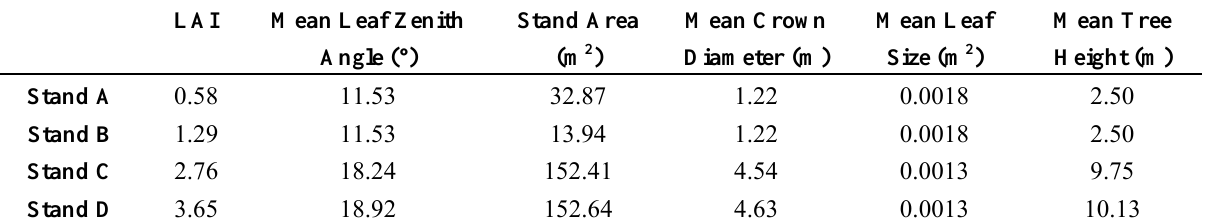
Table 1. Stand geometric information of the geometrically explicit 3D